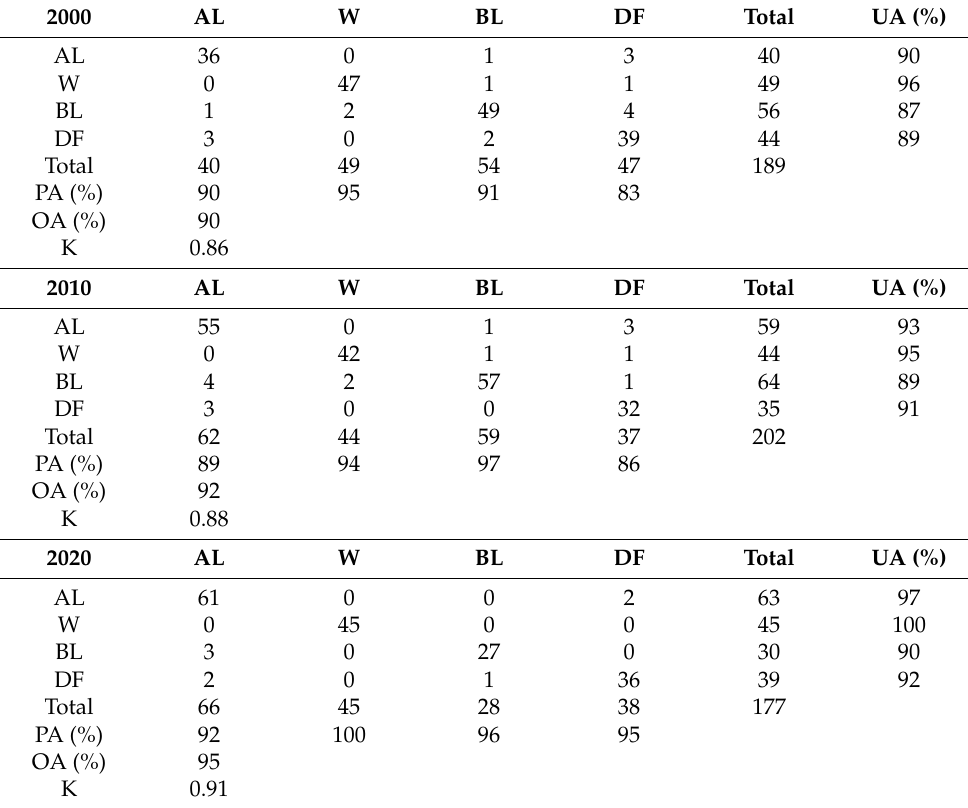
Table 3. Accuracy assessment of the LULC classifications in the Perak River